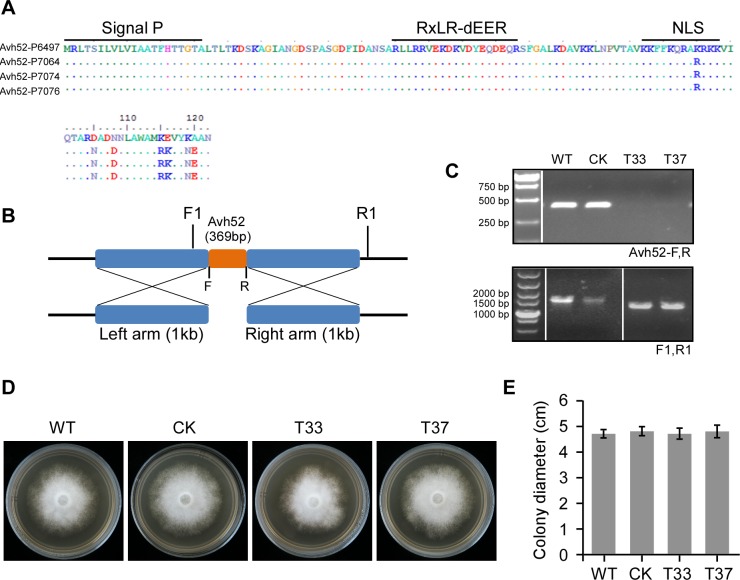
Knock out of PsAvh52 using the CRISPR/Cas9 System.(A) PsAvh52 is conserved in strains representing four principal genotypes (Forster, 1994), P6497, P7064, P7074, P7076. Dots indicate identical amino acids. Colors indicate chemical natures of amino acids. (B) Strategy for PsAvh52 gene deletion using the CRISPR/Cas9 system. PsAvh52 was deleted using homologous donor recombination. The sizes of the left and right arms are 1 kb. The knock-out mutants were screened by primer pairs F1/R1 and PsAvh52-F/R. (C) Genomic PCR analysis demonstrated that PsAvh52 was completely deleted in mutants T33 and T37 but not in control transformant CK. (D, E) The growth rate of PsAvh52 mutants compared to WT and CK on 10% V8 medium. Data are the means ± s.d. of three independent biological replicates. No significant differences were observed based on Student’s t test.